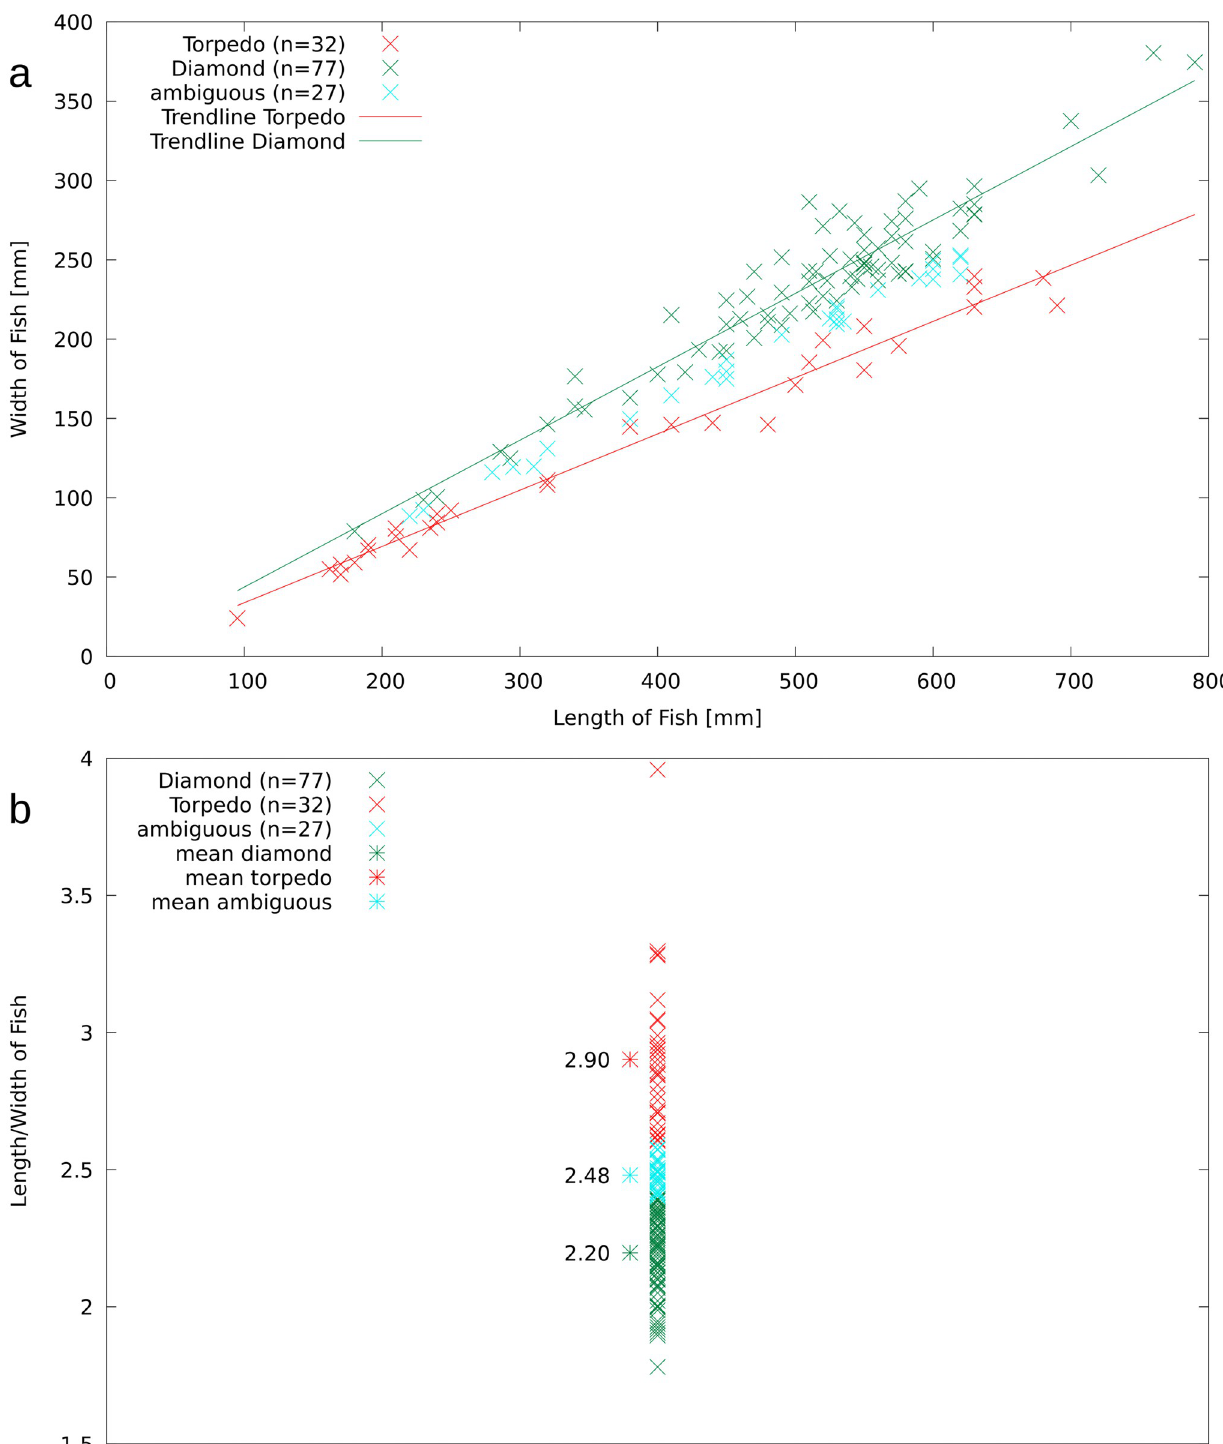
Fig 3. Body length of T . formosa in relation to body depth (A). Diamond-shaped individuals are deeply keeled and twice as long as wide, in contrast to torpedo-shaped individuals that are three times longer than wide with a more streamlined body outline (B).